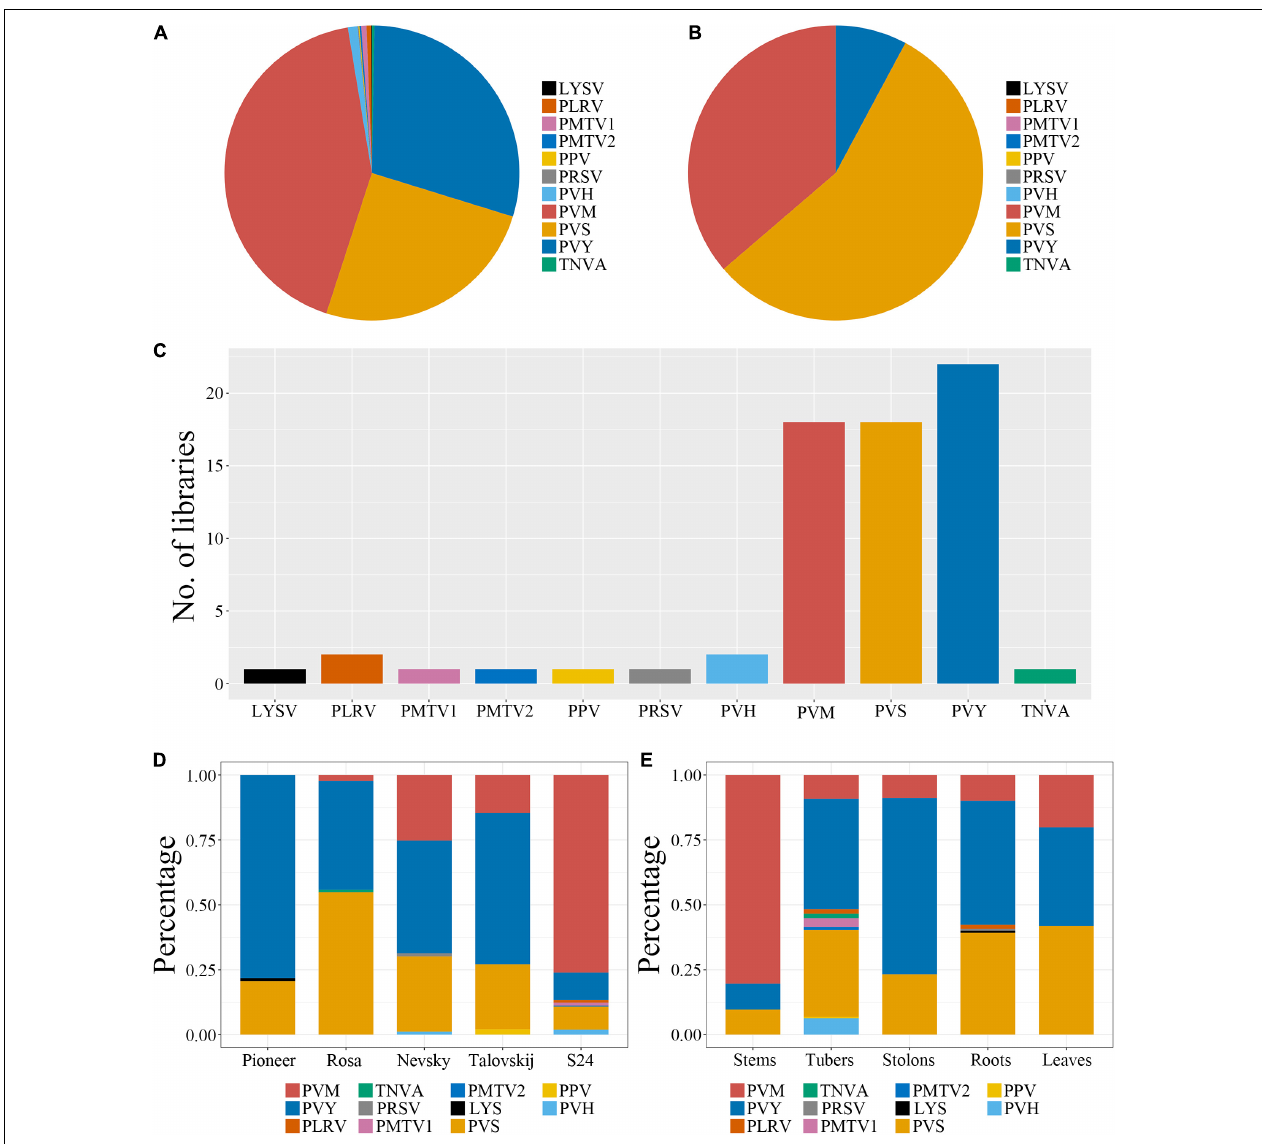
FIGURE 2 | Identification of viruses infecting potatoes and proportion of identified viruses in each library. (A,B) Proportions of identified viruses from all 22 libraries based on virus-associated contigs and reads, respectively. (C) Number of libraries for an individual identified virus. (D,E) Proportion of identified viruses among different cultivars and tissues, respectively, based on virus-associated